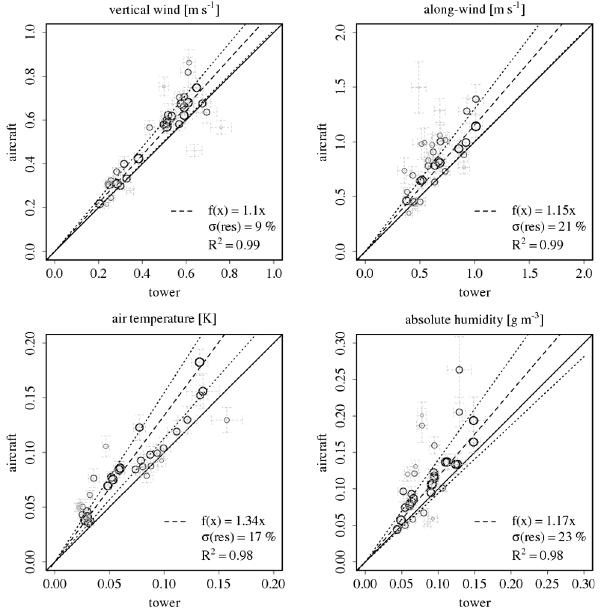
Fig. 4. Comparison between tower and WSMA standard deviations. The results are displayed in the same way as Fig. 2. Additional in- formation is given in the